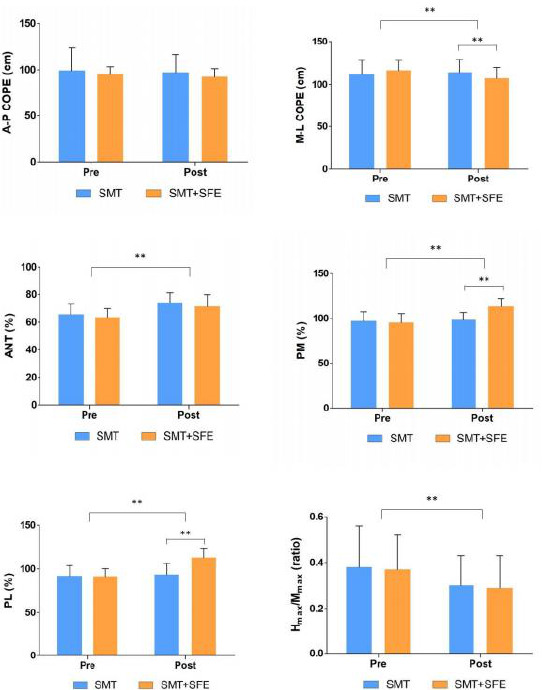
Figure 3. Result of post-hoc analysis between both groups. Values are means ± SD. ** Significant difference between groups ( p < 0.01). Abbreviations: SMT, sensorimotor training; SFE, short foot exercise; A-P, anterior-posterior; M-L, medial-lateral; ANT, anterior; PM, posteromedial; PL, posterolateral; H max , maximal H-reflex; Mmax, maximal M-wave.